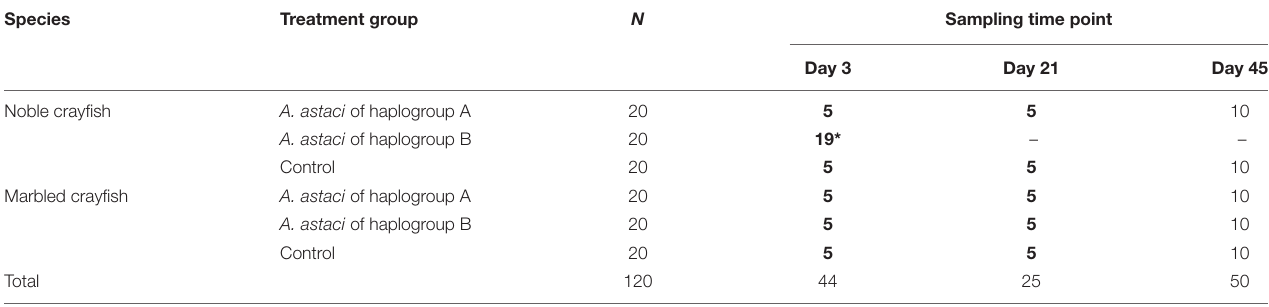
TABLE 1 | Study design and sampling time point. Species Treatment